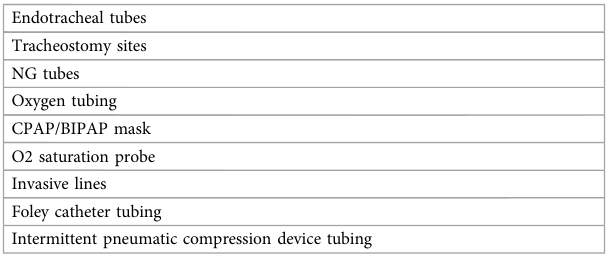
TABLE 7 Recommendations for off-loading of medical devices to decrease pressure injuries in critically ill